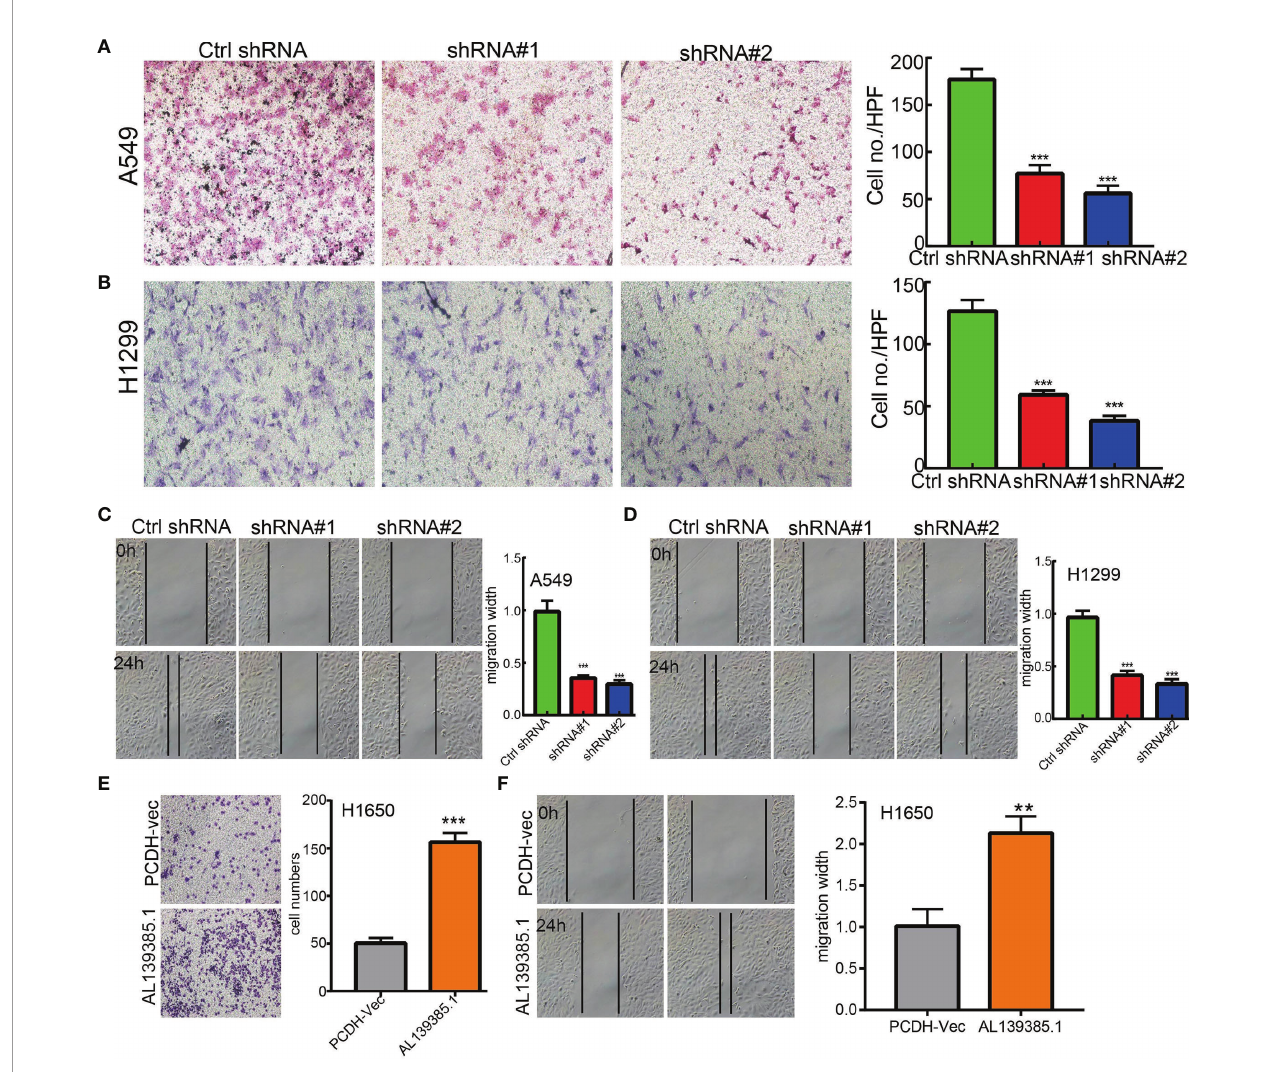
FIGURE 11 | lncRNA-AL139385.1 regulates LUAD cell migration in vitro . (A, B) Knockdown of lncRNA AL139385.1 dramatically inhibits A549 and H1299 cells migration ability examined by transwell assay. (C, D) Knockdown of AL139385.1 dramatically inhibits A549 and H1299 cell migration ability examined by wound healing assay. (E, F) Overexpression of AL139385.1 signi fi cantly promotes cell migration in H1650 cells, as measured by transwell and wound healing assay. **P<0.01 and ***P<0.001. shRNA#1, AL139385.1 shRNA#1; shRNA#2, AL139385.1 shRNA#2; AL139385.1,